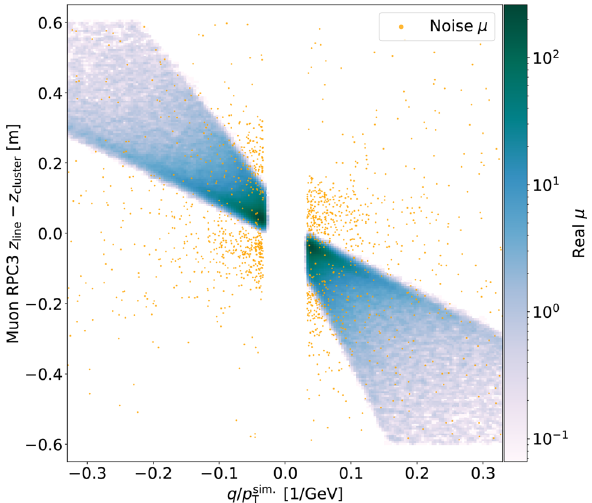
Fig. 4 Differences of z coordinates between the impact point of the seed line and the cluster position in the RPC3 layer plotted as a function of simulated muon 1 / p T . Colour coded density map shows candidates with only muon hits. Orange dots show candidates that include at least one noise